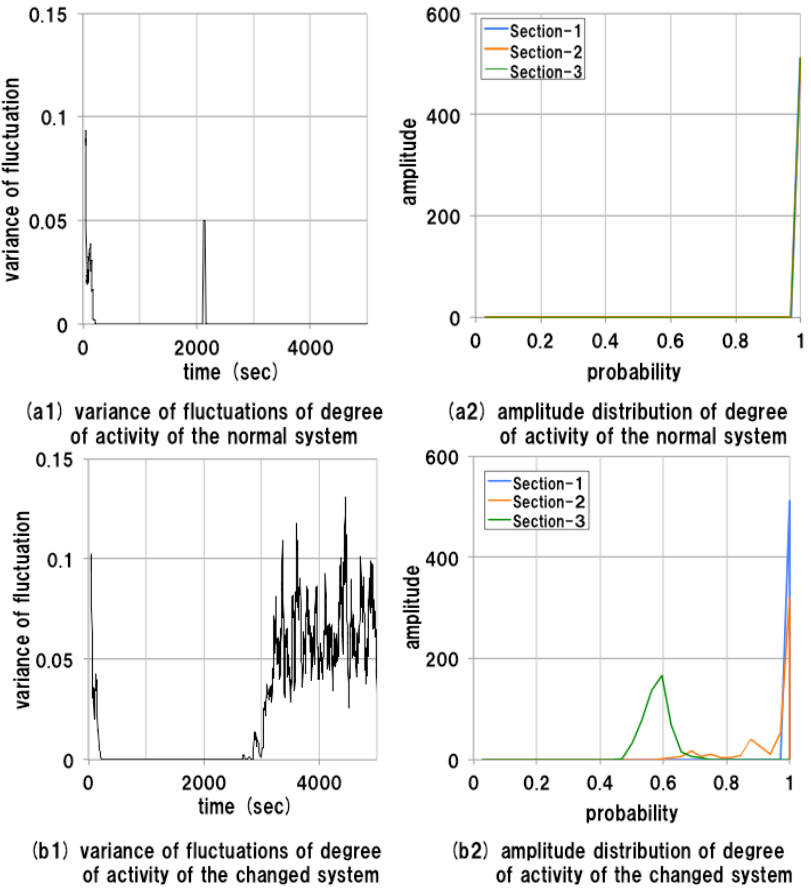
Figure 9. Results of measurements of the manager